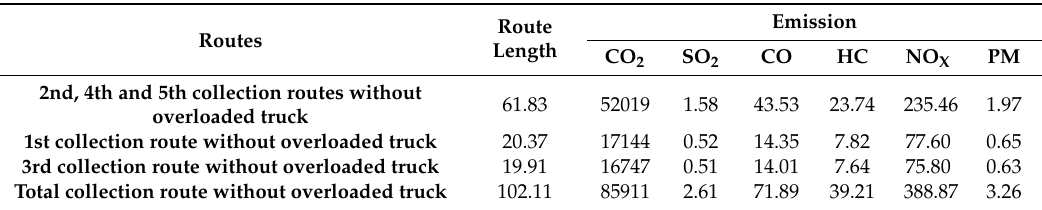
Table 5. Calculated emission of collection routes in Scenario 2.